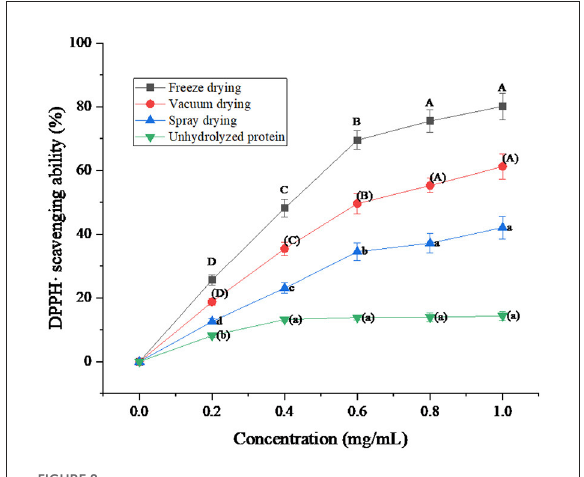
FIGURE8 DPPH · scavenging ability of protein peptide powder by three dry methods. Different letters express significant differences ( p <